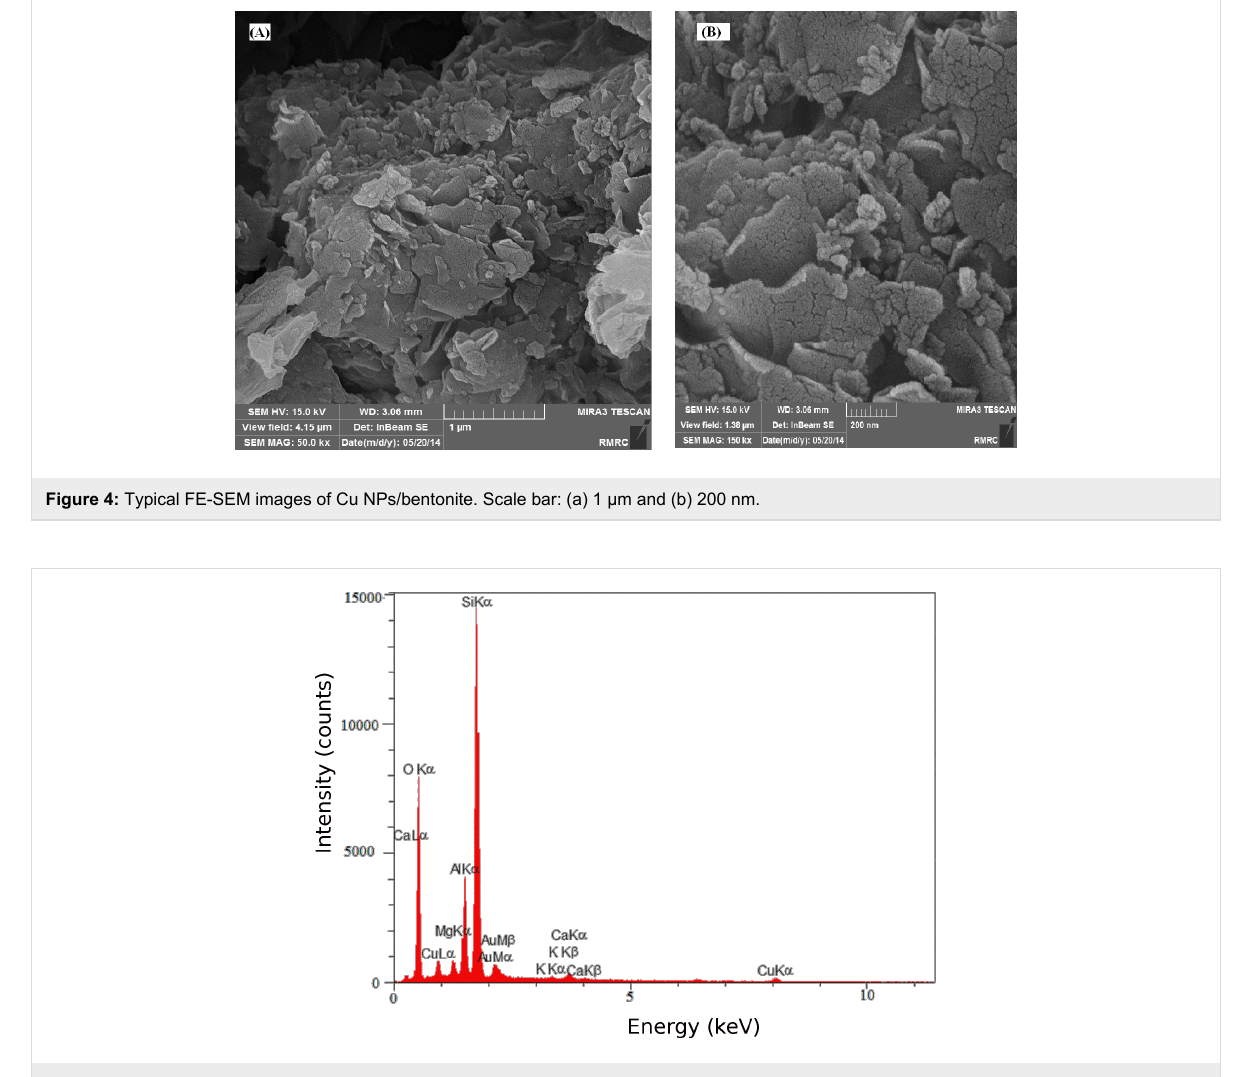
Figure 5: EDS spectrum of Cu